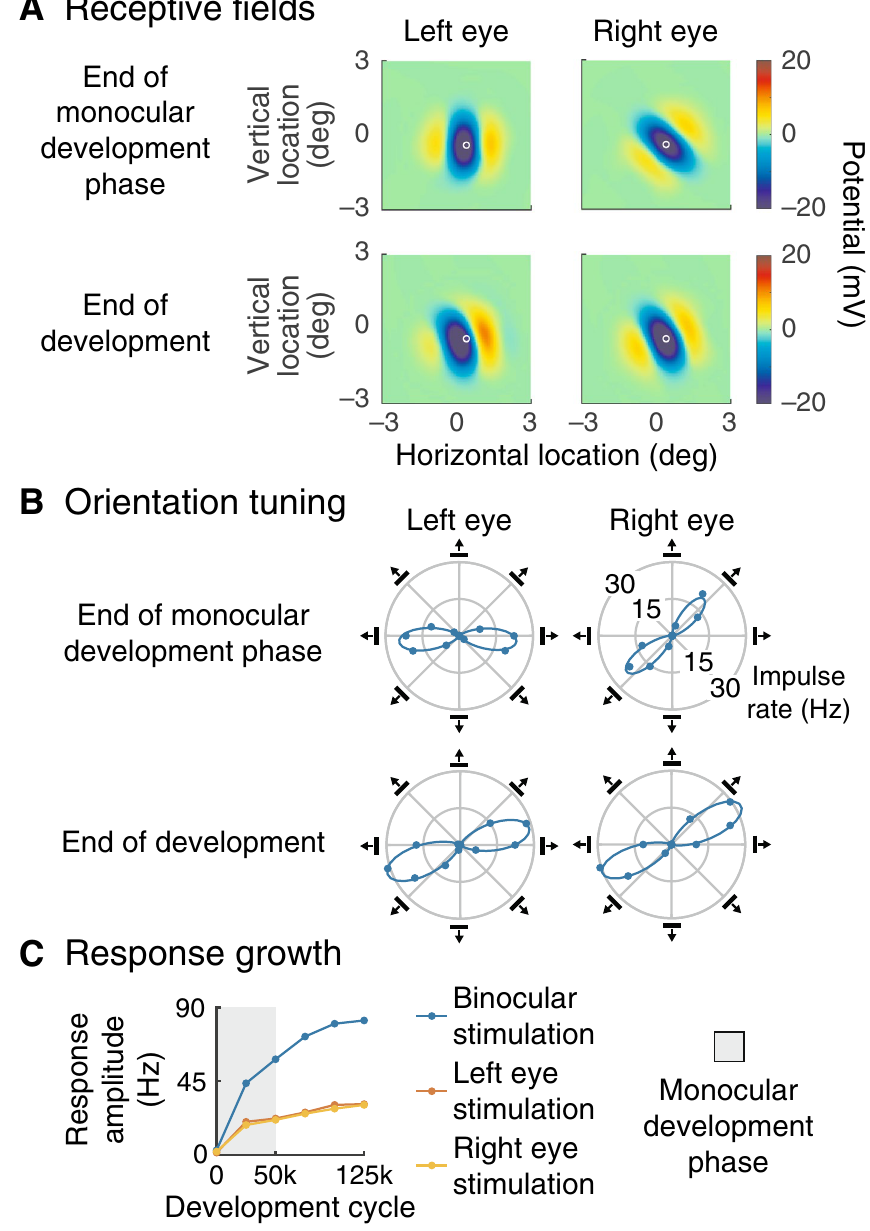
Figure 4. Binocular development in a single neuron. ( A ) This shows receptive fields for the neuron whose synaptic modulations are given in Fig. 2; the white circle shows the neuron’s location. Fields were calculated by presenting a square of light or dark at a range of visual field locations, subtracting responses to dark from those to light, and interpolating across locations. Generator potential was used to represent the response because it reveals decrements as well as increments. The left and right plots are for stimuli delivered to the left and right eye respectively. The orientation of the subfields at the end of the first (upper row) and second (lower row) phases of development reflects the orientation of the synaptic modulation segregation in Fig. 2B,C, respectively. ( B ) To illustrate orientation tuning, gratings with a variety of directions were drifted over the receptive fields of the same neuron as in ( A ). The polar plots give the fundamental Fourier amplitude of impulse rate: amplitude is shown by distance from the origin, and direction by the angle of the plotted point from the horizontal. The icons around the plot show both the orientation of the grating and its motion direction, and the curve fitted to the points is a sum of von Mises functions. There is a clear misalignment of preferred orientation between the eyes at the end of the monocular development phase (upper row). The left and right eye orientation tunings are almost aligned by the end of the second development phase (lower row). ( C ) The horizontal axis gives development cycle number and the vertical axis the response amplitude at the preferred orientation. The two lower curves show responses for monocular stimulation and the upper (blue) curve for simultaneous stimulation of both eyes. The first development phase is shown by the grey shading. Response amplitudes are very weak at the start of development and are close to asymptotic at the